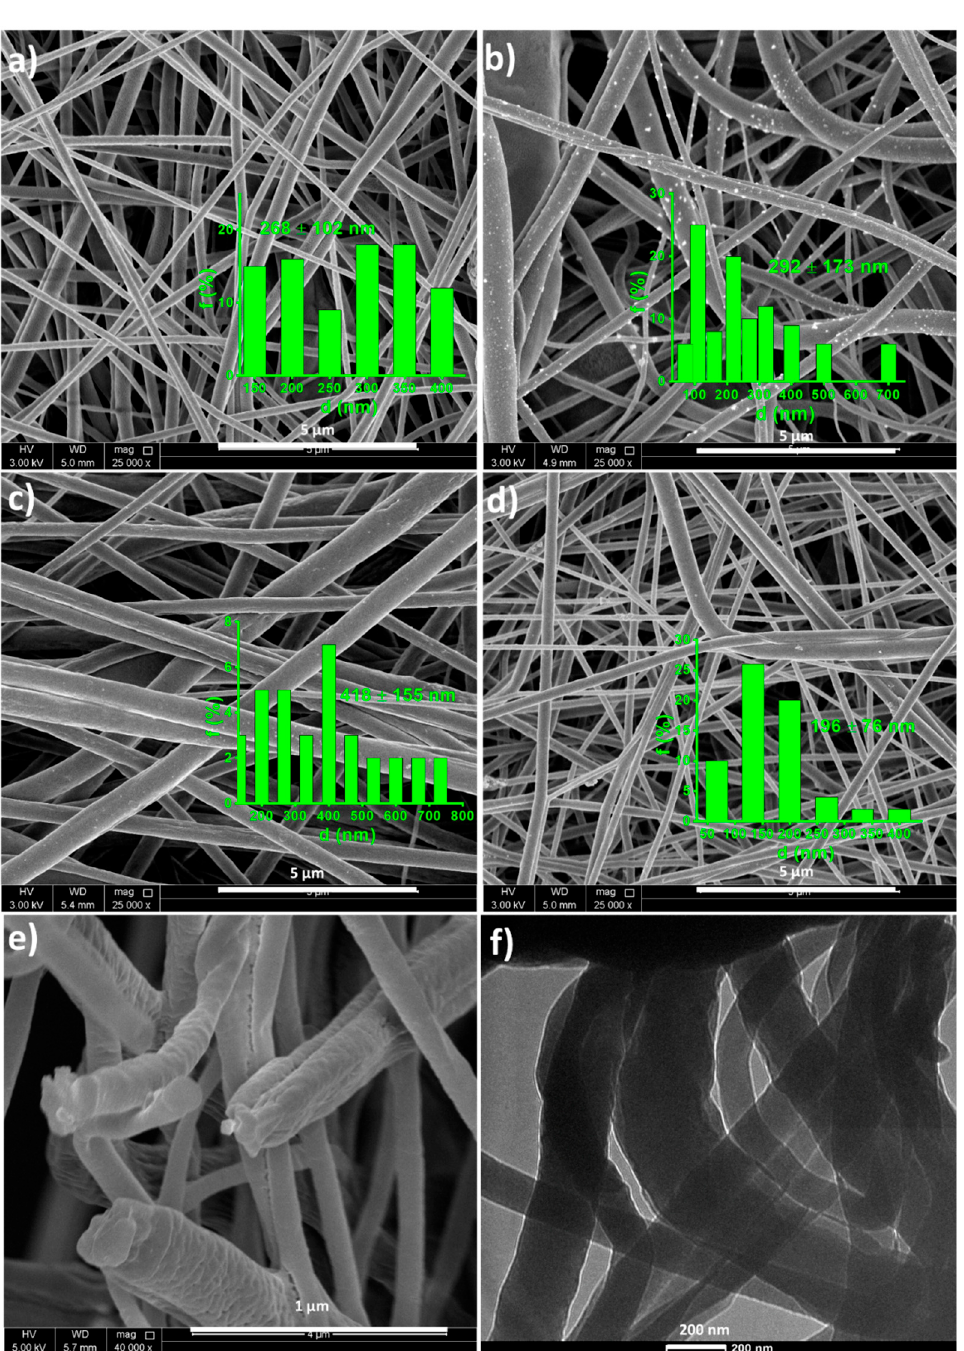
Figure 3. SEM images of ( a ) PH-PF ( b ) PH-PFZ ( c ) PH-PFT ( d ) PHT-PFZ composite fibers, ( e ) PHT-PFZ cross sectional SEM image and ( f ) TEM image of PHT-PFZ fibers.